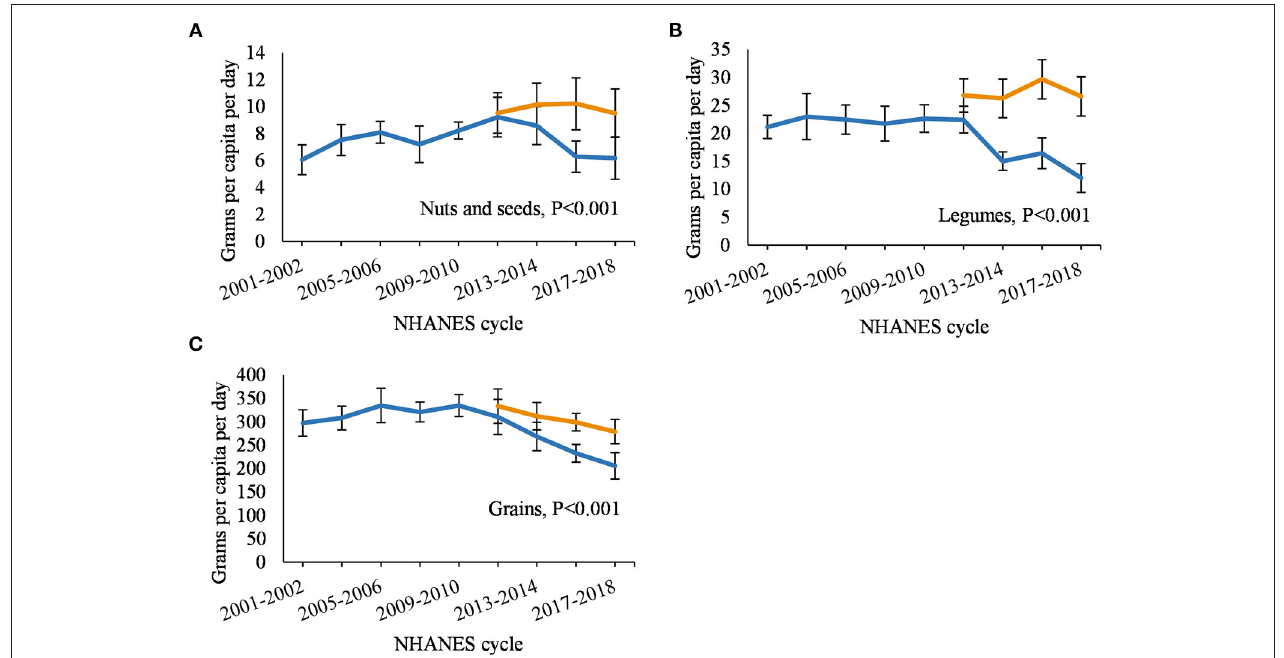
FIGURE 2 | Annual per capita food intake among US adults from 2001 to 2018 comparing updated and non-updated Food Commodity Intake Database (FCID). (A) nuts and seeds; (B) legumes; and (C) grains. FCID, Food Commodity Intake Database. Differences between trend lines were evaluated using paired Wald tests adjusted for age, gender, energy intake. Data from 2009 to 2010 were used as the regression